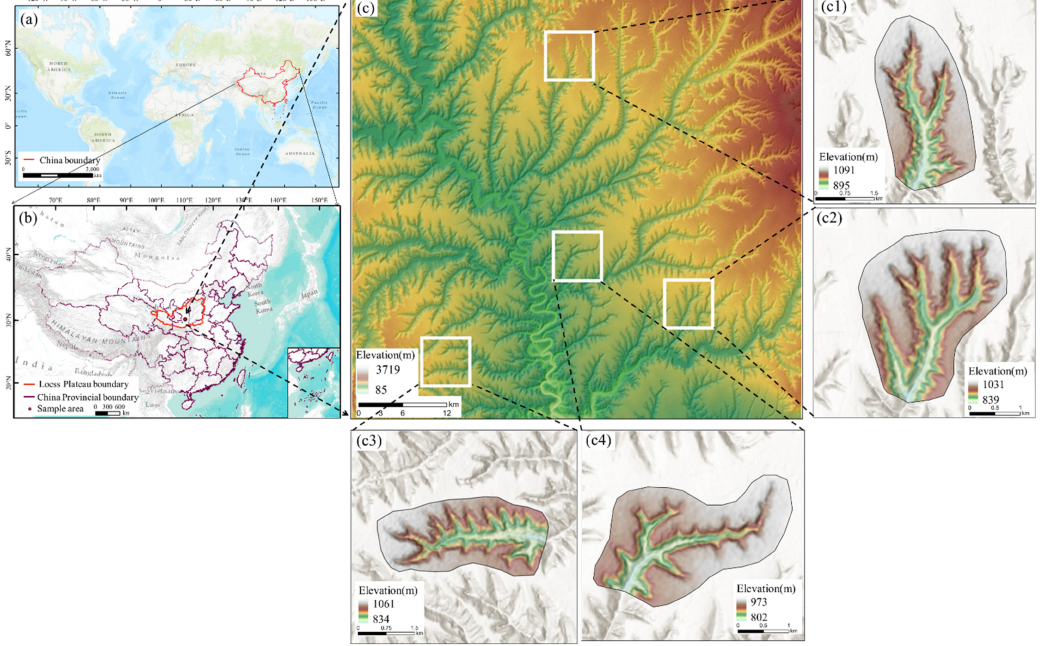
Figure 2. Location of the study area: ( a , b ) location of Loess Plateau; ( c , c1 – c4 ) hillshade map of the study